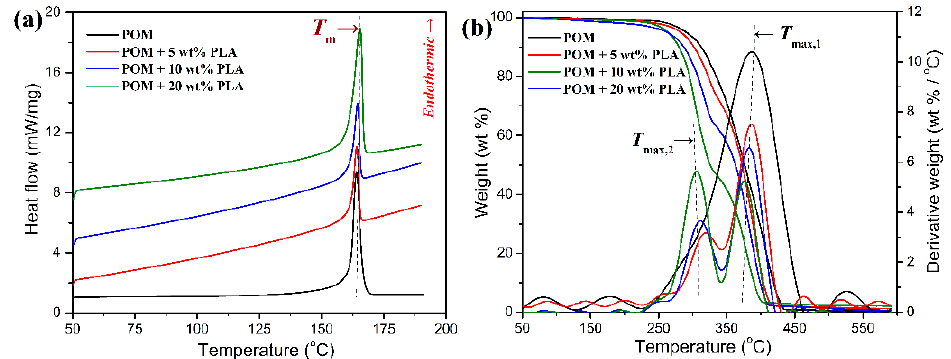
Figure 3. ( a ) Differential scanning calorimetry (DSC), and ( b ) thermogravimetric analysis (TGA) thermograms of POM/PLLA blends at different contents of PLLA.